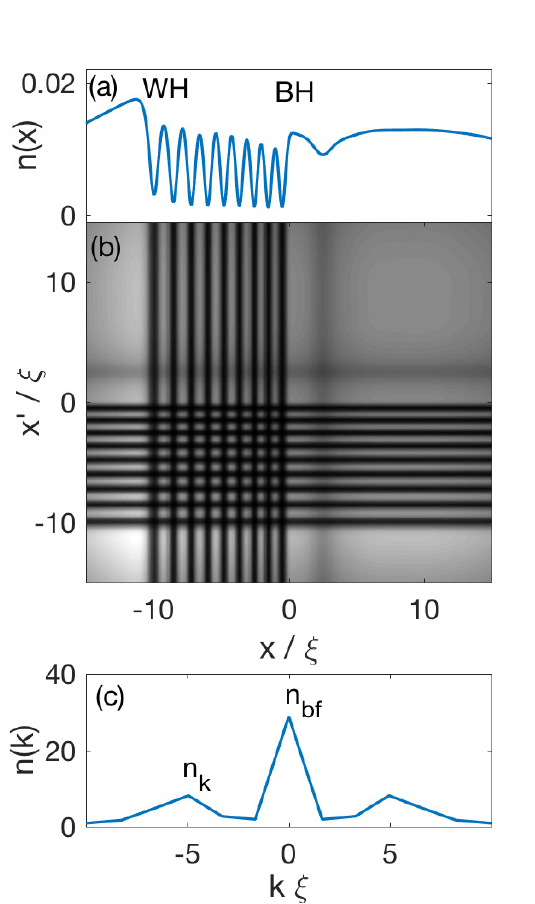
Figure 2: GP simulation and its wavevector spectrum at t = 120 ms. (a) density plot n ( x ) ; (b) density-density plot, n ( x ) n ( x (cid:48) ) ; (c) wavevector spectrum n ( k ) for the condensate density between the BH and the WH. The central peak indicates the background density, n side peaks indicate the standing wave amplitude, n